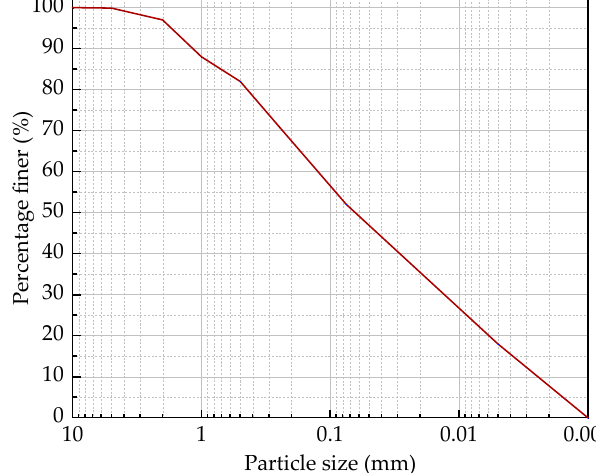
Figure 1. Particle size distribution curve of BTs. Table 1. Physical parameters and mineral composition of BTs.